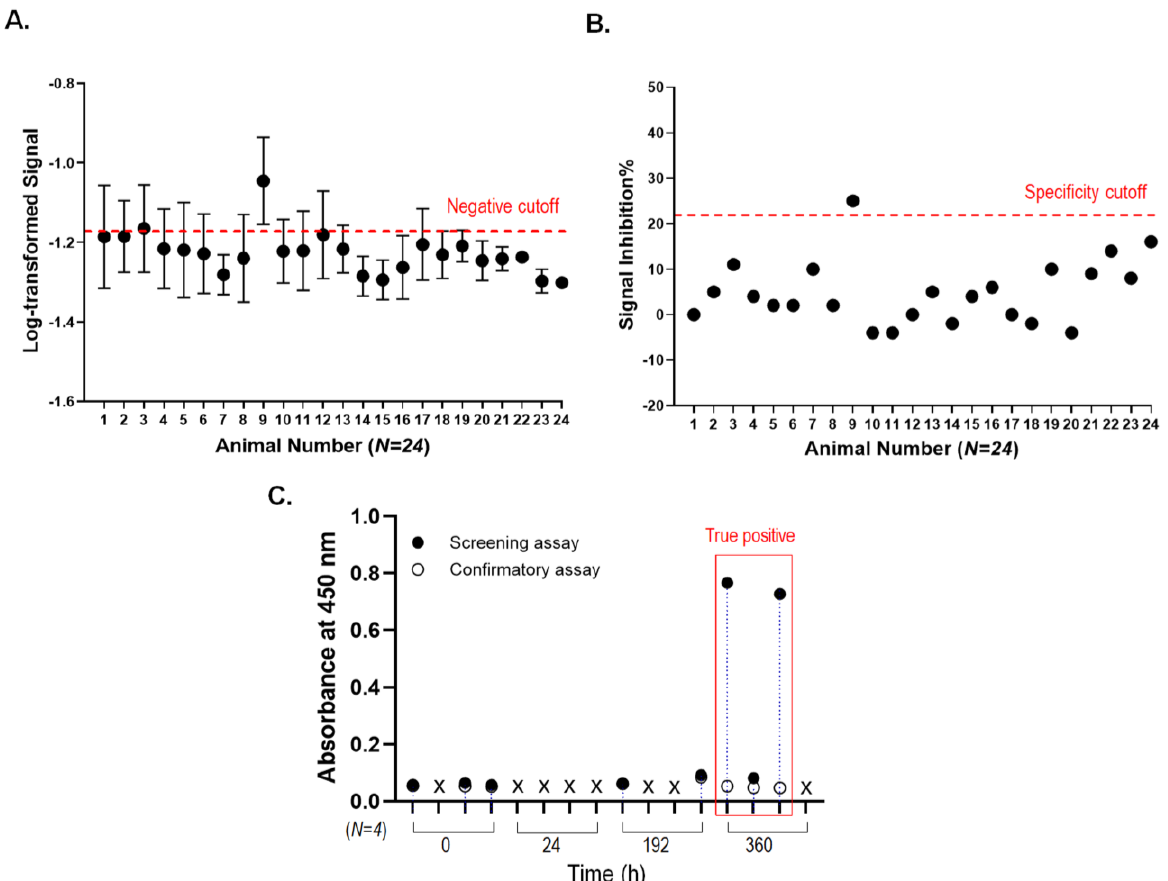
Figure 3. Immunogenicity assessment of T-DM1 in rats administered intravenously with a single dose. ( A ) Negative cutoff value and ( B ) specificity cutoff values were determined with the blank sera of 24 individual rats. The 95th percentile among the log-transformed values was defined as the negative cutoff, and the signal inhibition for specificity cutoff value was calculated as the mean %difference between T-DM1-untreated and T-DM1-treated individuals. ( C ) Screening and confirmatory assays were performed to discriminate ADA positivity against T-DM1. The previously set negative cutoff and specificity cutoff were applied. Following the screening assay, samples were categorized as either positive (marked as closed circles) or negative (marked as X). The positive samples were then subjected to confirmatory immunocompetition assay (marked as open circles) to differentiate between true and false positive results. True ADA-positive samples for T-DM1 are described in the red box.